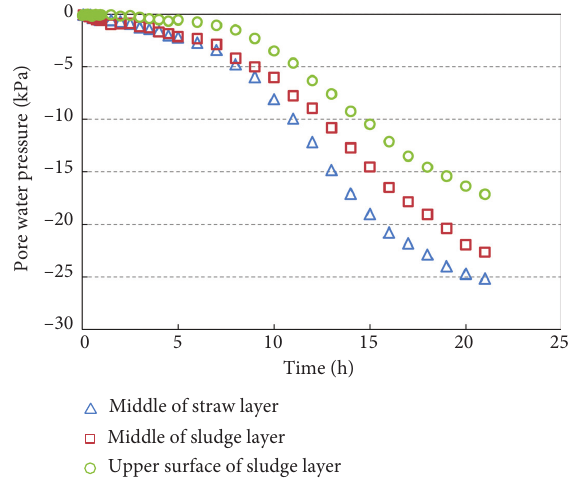
Figure 14: The pore water pressure at the monitoring